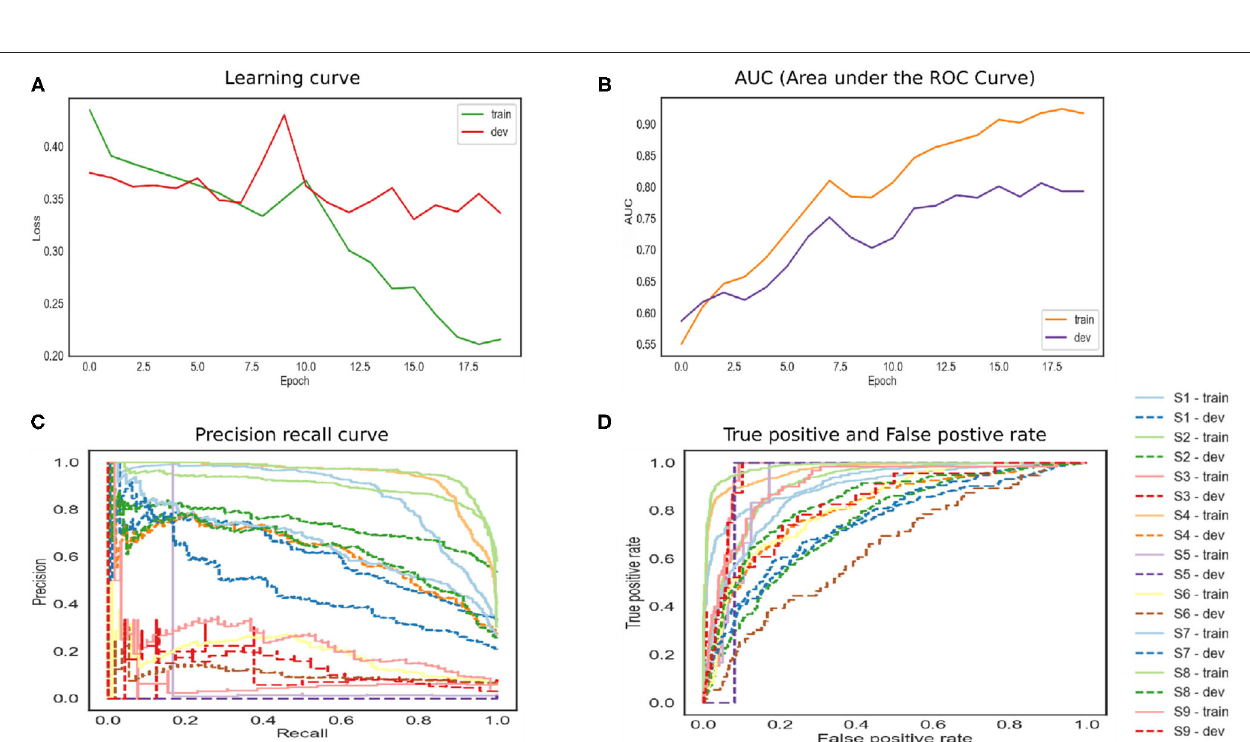
FIGURE 5 | The performance of bidirectional Long Short-Term Memory (LSTM) model.